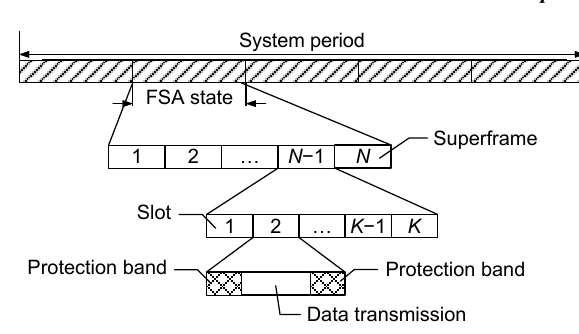
Fig. 1 Intersatellite network handling scheme.